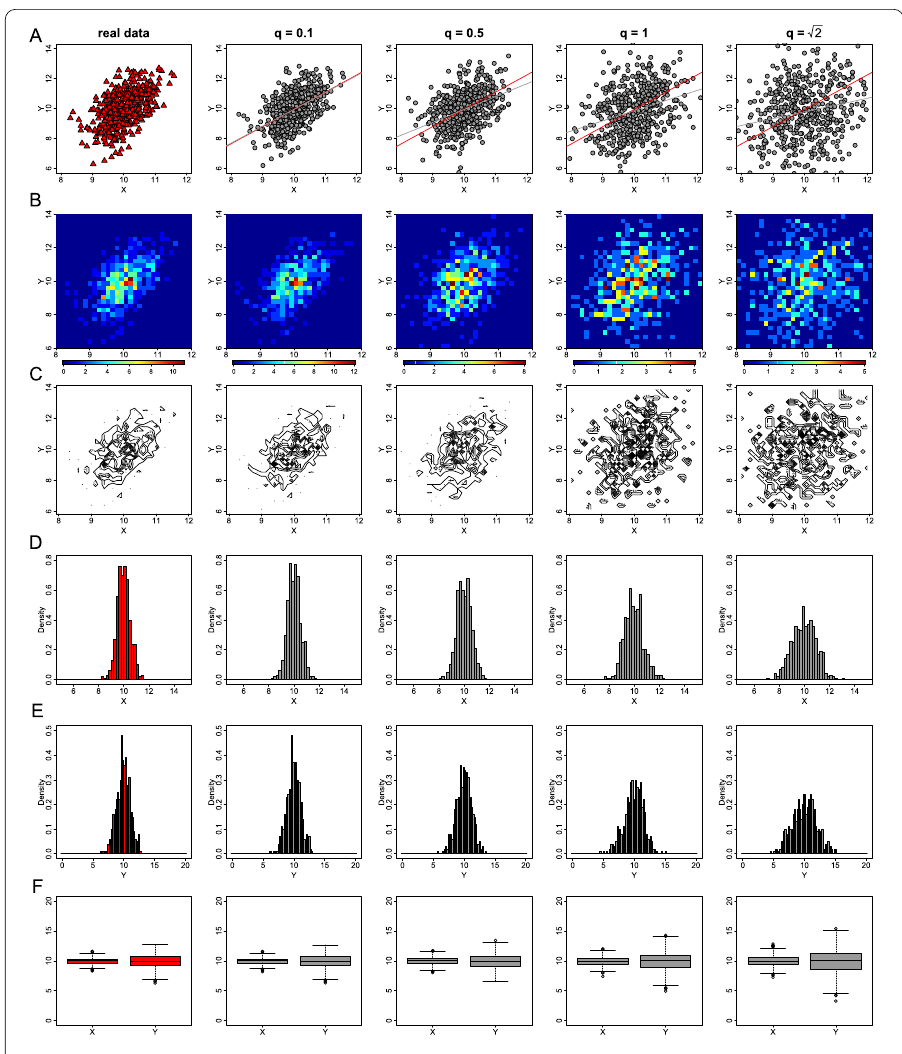
Figure 14 The effect of parameter q of the probabilistic anonymization method on exploratory data visualizations. From left to right we demonstrate the effect of q for the values of 0 (this is equivalent to the real √ 2 on generating privacy-preserving scatter plots ( A ), heat map plots ( B ), contour plots data), 0.1, 0.5, 1 and ( C ), histograms of X ( D ) and Y ( E ), and box plots ( F